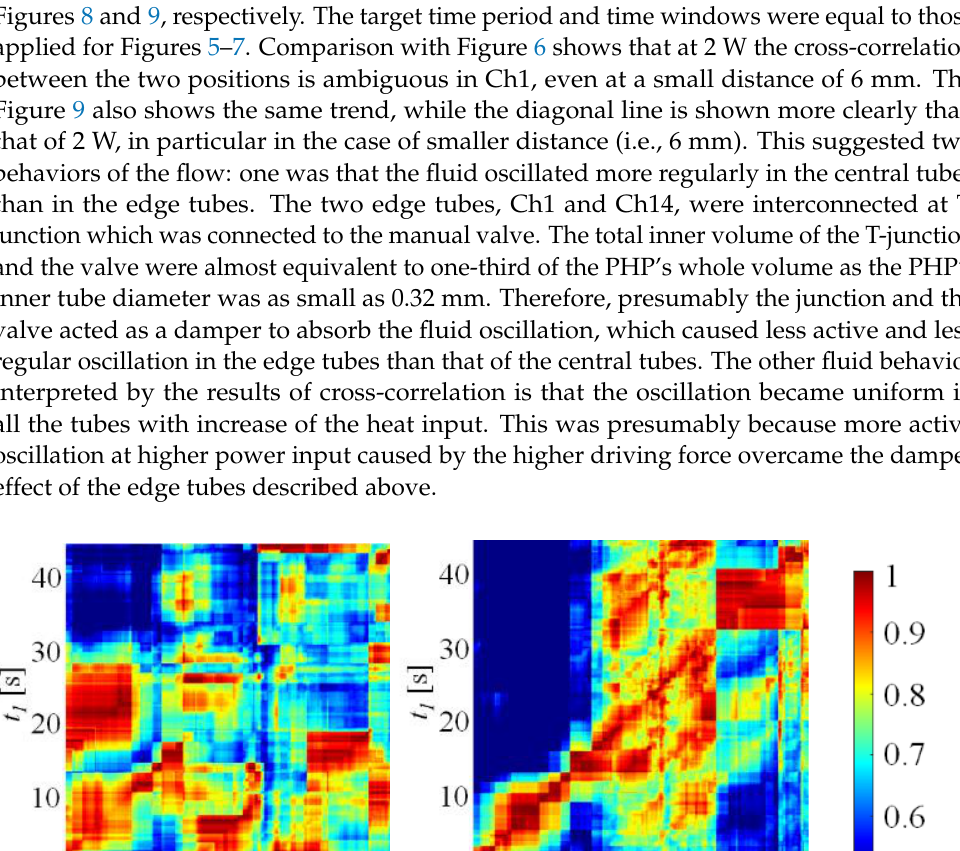
Figure 7. Cross-correlations of heat fluxes at two positions of Ch7 at Q ele = 3.5 W, ( a ) 7a and 7d, ( b ) 7c and 7d.